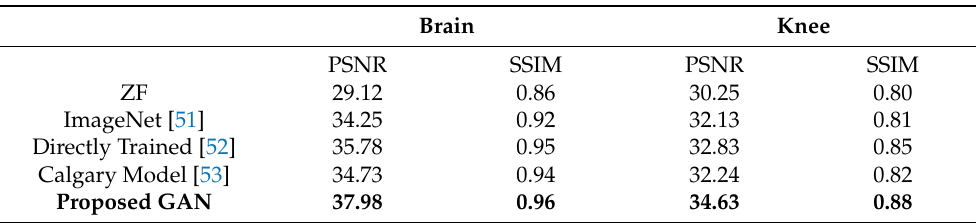
Table 2. Quantitative analysis of PSNR and SSIM values acquired from brain and knee test images using various reconstruction techniques. Brain